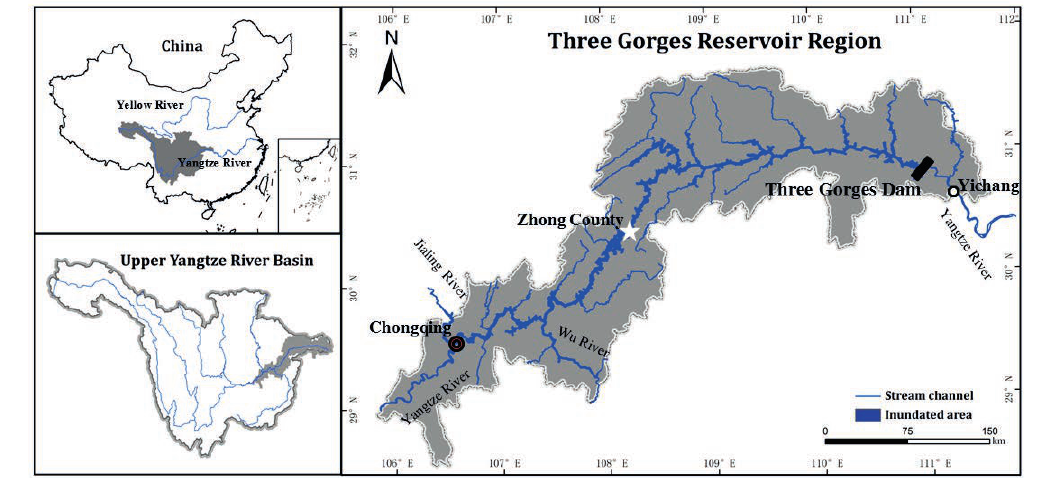
Fig. 1 Geographical map of the Three Gorges Reservoir and location of the study